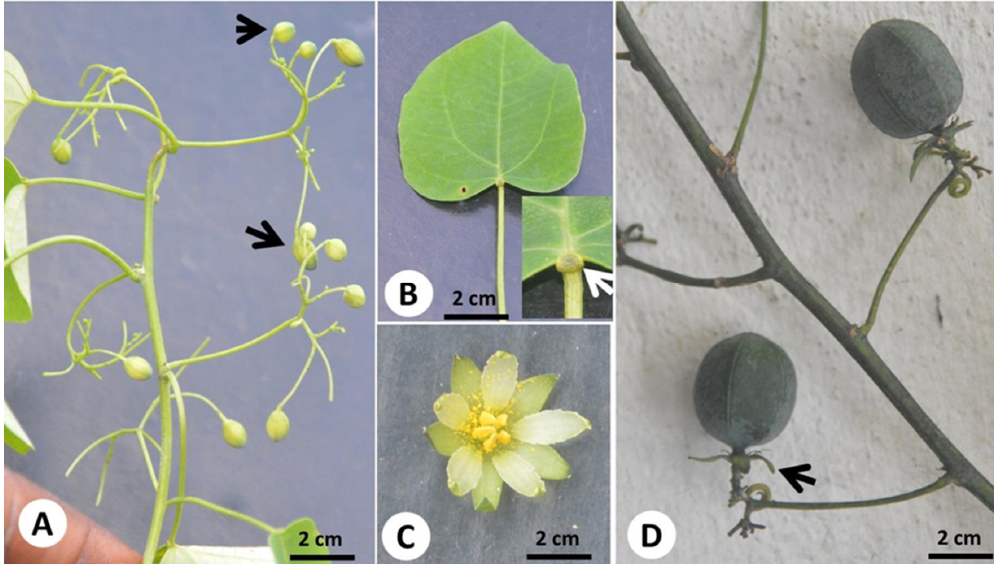
Figure 2(A-D): A. cissampeloides (A) Plant habit (arrows show flower buds), (B) Leaf (arrow shows glands), (C) Flower, and (D) fruits (arrow shows persisted sepals)